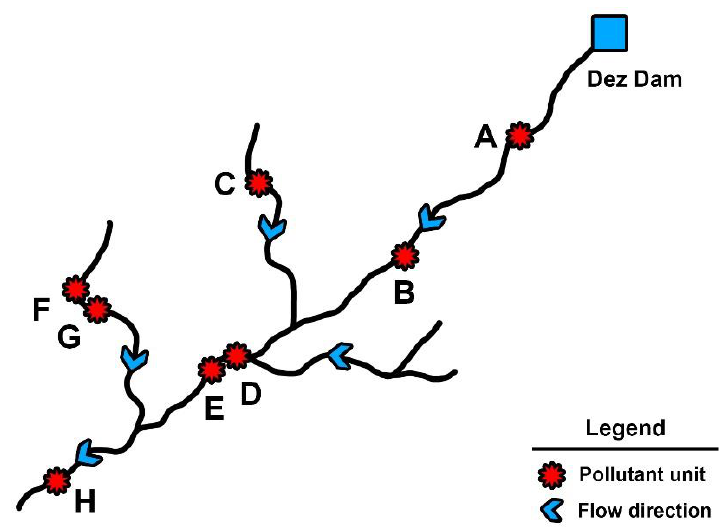
Figure 2. The catchment area of the Dez and Karoon rivers.